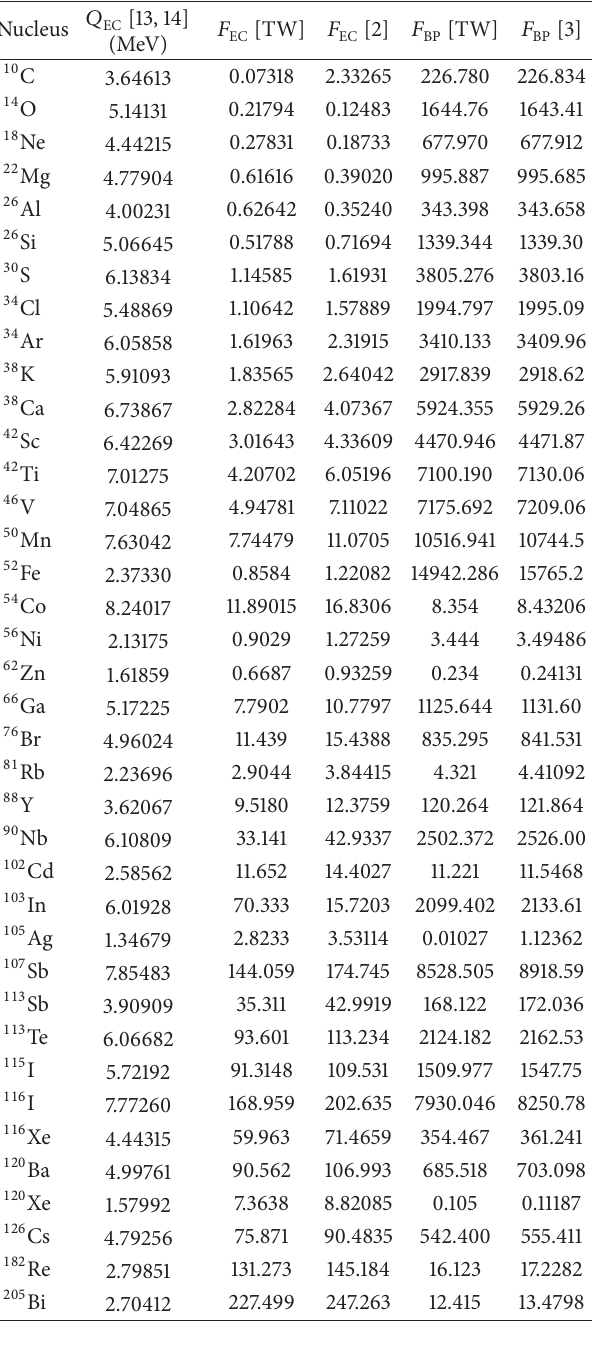
Table 4: Calculated phase space factors 𝐹 with 𝑄 -values from [13,